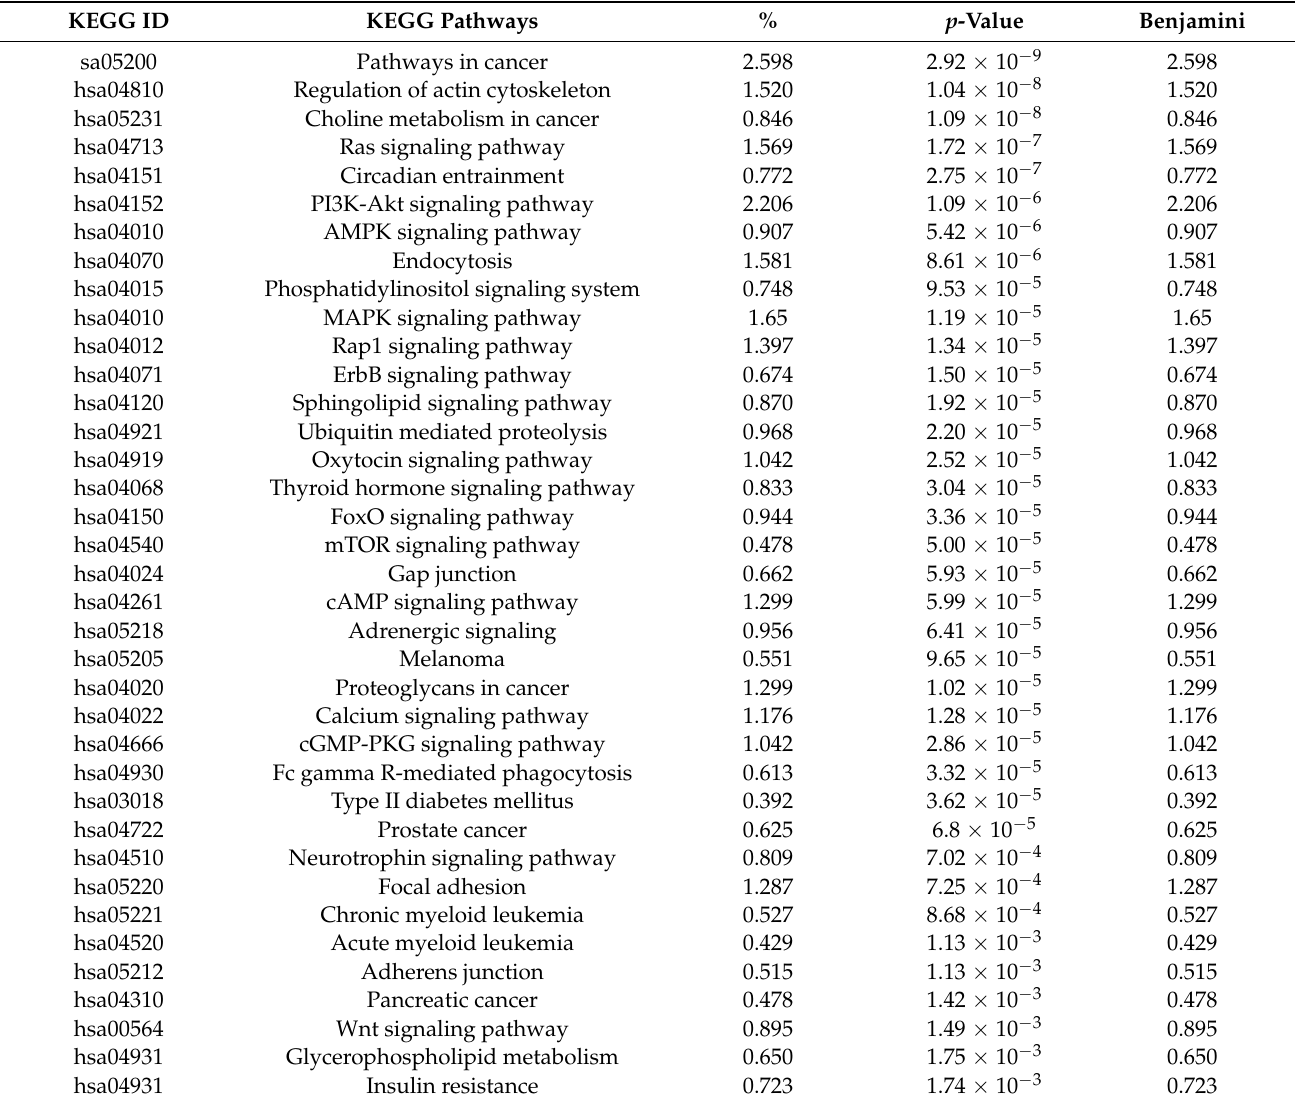
Table 1. List of KEGG pathways involved in 8172 unique gene target predictions found in 46 miRNAs in 1424 cells exposed to IH compared normoxia.